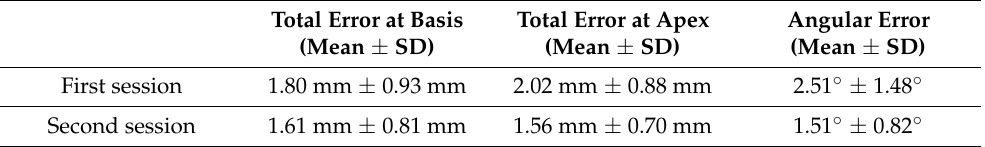
Table 1. Imaged are the mean values and deviations of all students from the master typodont. The deviations of the angles of the implant positions and the exact positions in vestibular/oral and mesial/distal direction (basis) as well as in cranial/caudal direction (apex) were